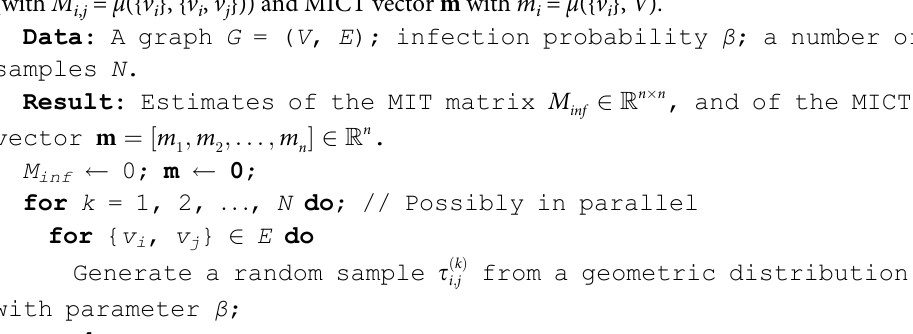
Algorithm 2 : Efficient Monte Carlo estimation of the mean infection time matrix M